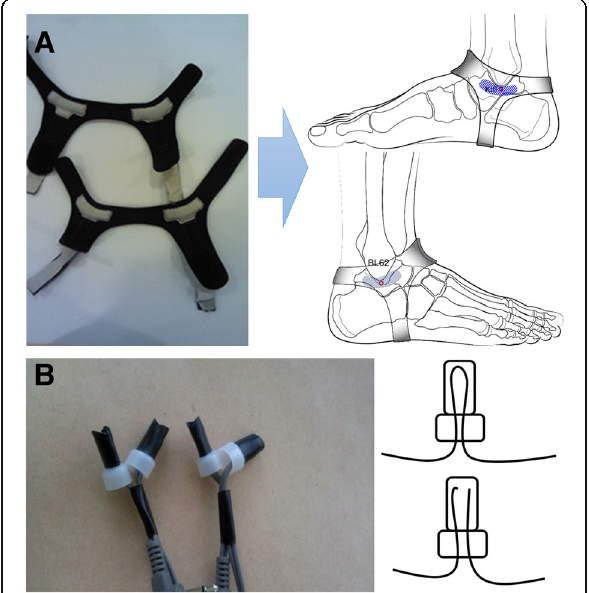
Fig. 2 The bands ( a ) and wires ( b ) used in this study. a Applying low- frequency electrical stimulation at the acupuncture points BL62 and KI6 to a participant while measuring electrical current. The low-frequency electrical stimulation was applied through a band specifically designed for selective stimulation at BL62 and KI6 in conjunction with the simultaneous measurement of electrical current. b Electrical wires used for low- frequency electrical stimulation. Wires with or without a cut were made in an indistinguishable fashion to maintain the double-blind